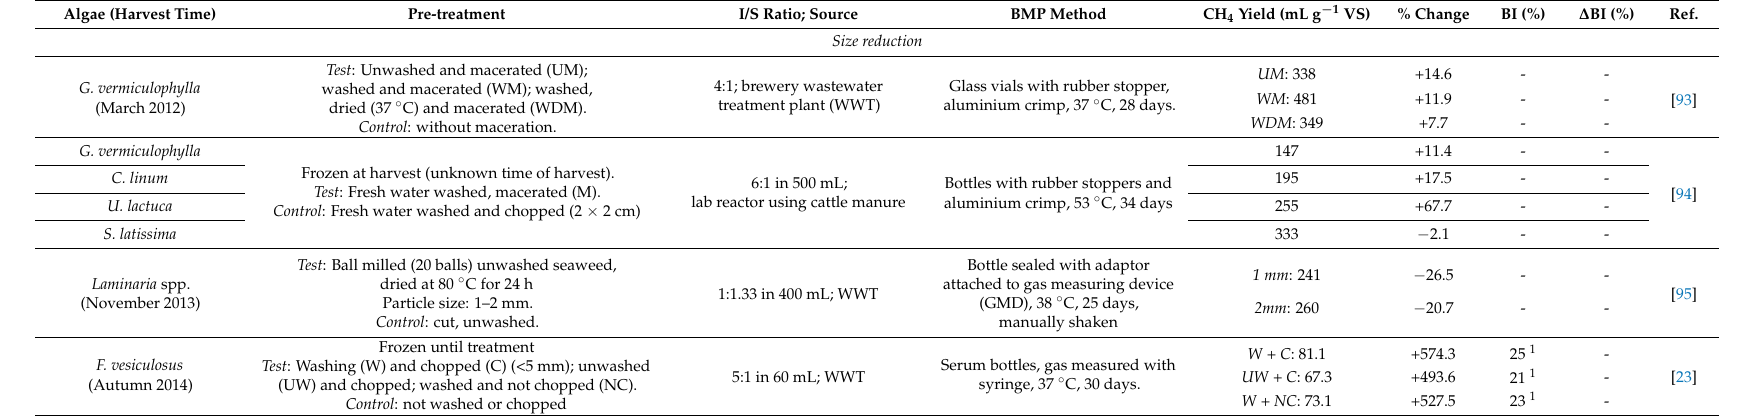
Table 3. Methane yields following mechanical pre-treatment of seaweed.